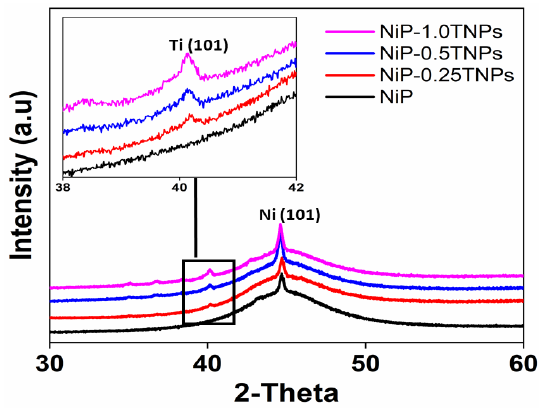
Figure 5. X-ray diffraction (XRD) graphs for NiP and NiP-TNPs nanocomposite coatings. Figure 5. X-ray di ff raction (XRD) graphs for NiP and NiP-TNPs nanocomposite